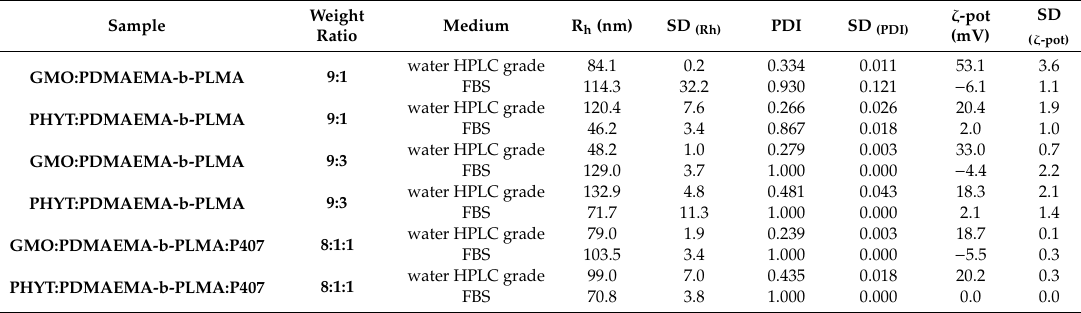
Table 3. The physicochemical characteristics of the prepared nanosystems in aqueous and biological medium (fetal bovine serum,